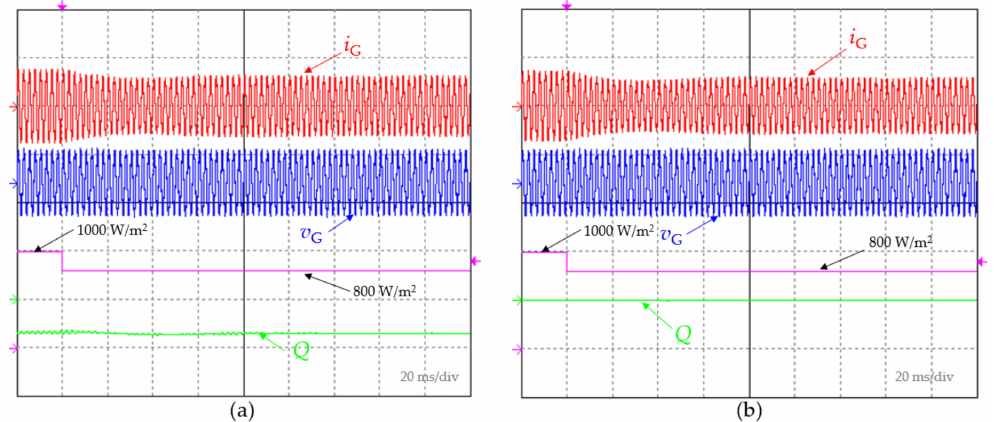
Figure 13. Solar irradiance jumps from 1000 W/m 2 to 800 W/m 2 : ( a ) waveforms of the grid voltage v G and grid current i G , the reactive power Q and the solar irradiance (pink) registered for the system without the reactive power compensation; ( b ) waveforms of the grid voltage v G and grid current i G , the reactive power Q and the solar irradiance (pink) registered for the system with the reactive power